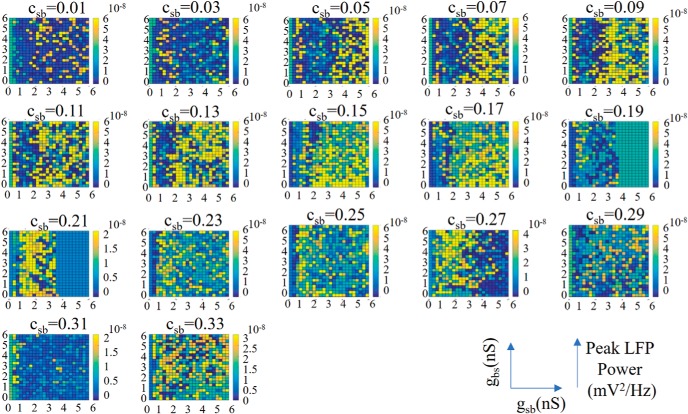
Peak power for all conductances and connectivities. Note that the color scale bars are not the same for all the plots. The plot for csb = 0.21 corresponds to Figure 7A.